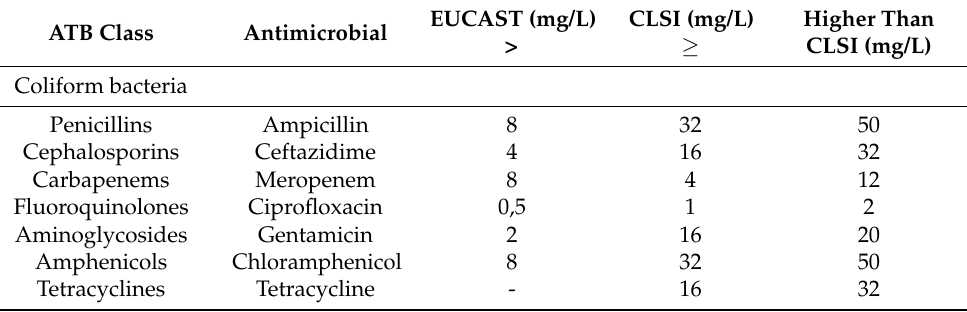
Table 3. Resistant breakpoints of ATBs used in susceptibility